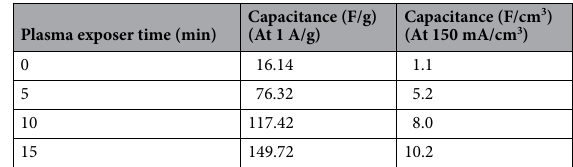
Table 1. Gravimetric and volumetric capacitances of the 0–15 min plasma-exposed supercapacitors.